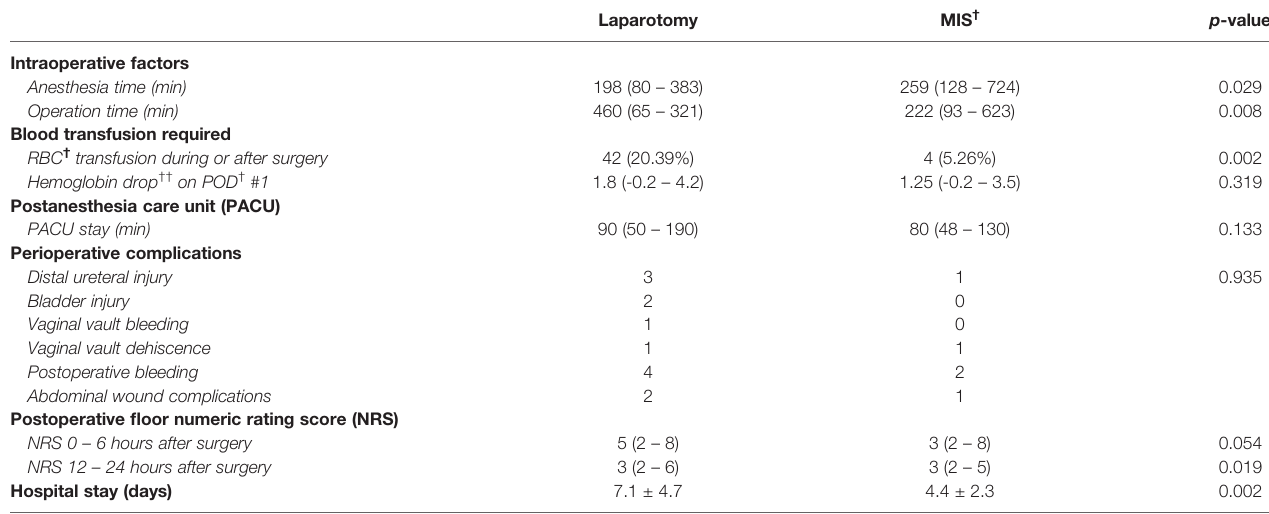
TABLE 5 | Perioperative outcomes.